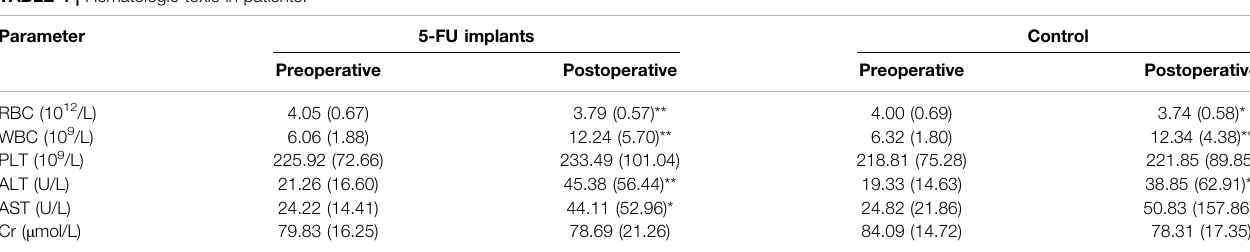
TABLE 4 | Hematologic toxic in patients.